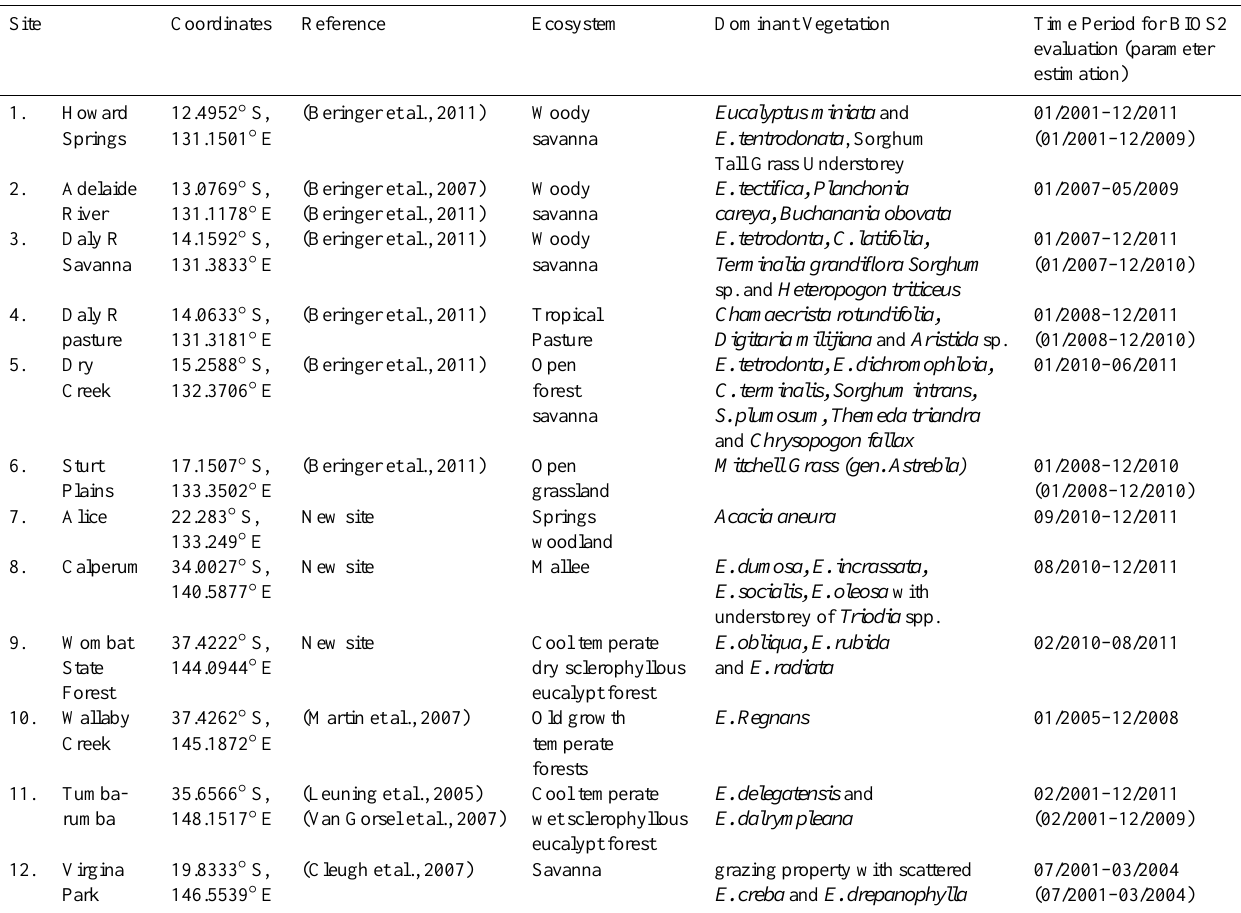
Table 1. Locations and characteristics of OzFlux sites, and the time-periods used for BIOS2 evaluation and, where applicable, parameter